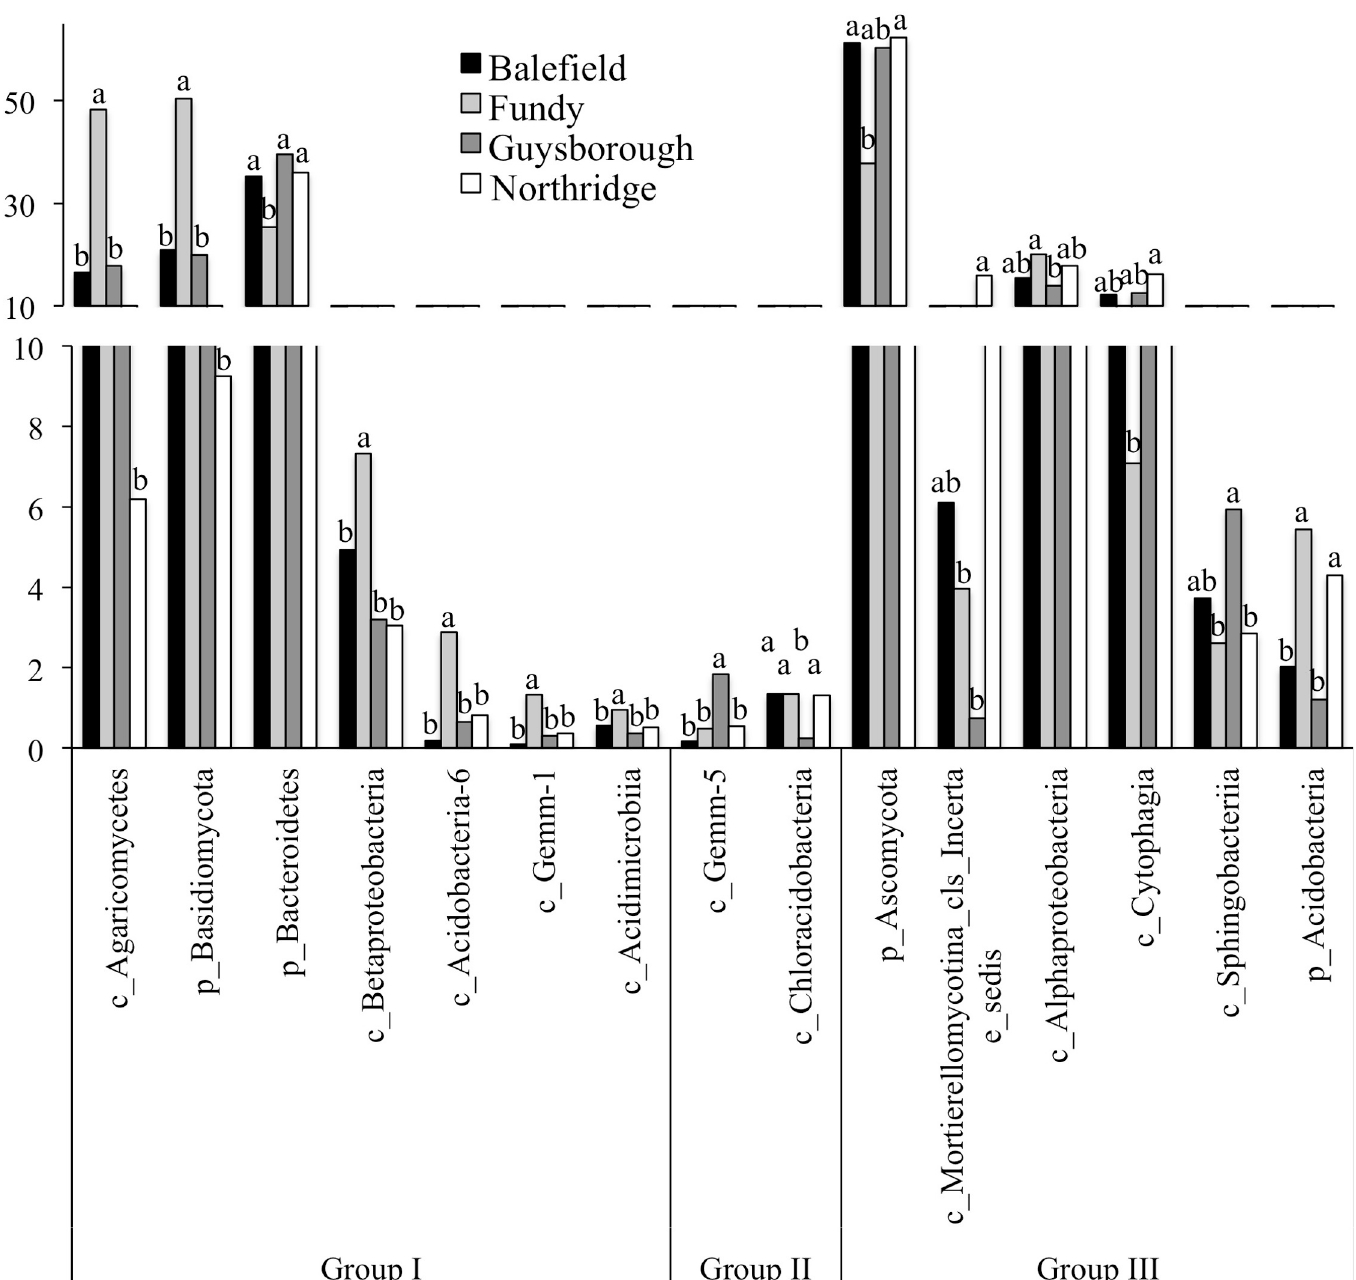
Fig 2. Microbial taxa those were significantly overrepresented in comparison between compost facilities. Corrected P-values (q-values) were calculated based on Benjamini-Hochberg FDR multiple test correction. Features with (Welch’s t-test) q value < 0.01 were considered significant and were thus retained. Group I–Microbial taxa that were significantly overrepresented or underrepresented in Fundy facility compared with other facilities; only microbial taxa represented by > 500 total reads. Group II–Microbial taxa that were significantly overrepresented or underrepresented in Guysborough facility compared with other facilities; only microbial taxa represented by > 500 total reads were considered; Group III–Microbial taxa represented by more than 5% of total reads and differed in their relative abundances between facilities. For each variable, data followed by different letters are significantly different according to Tukey’s pairwise test (P < 0.05).